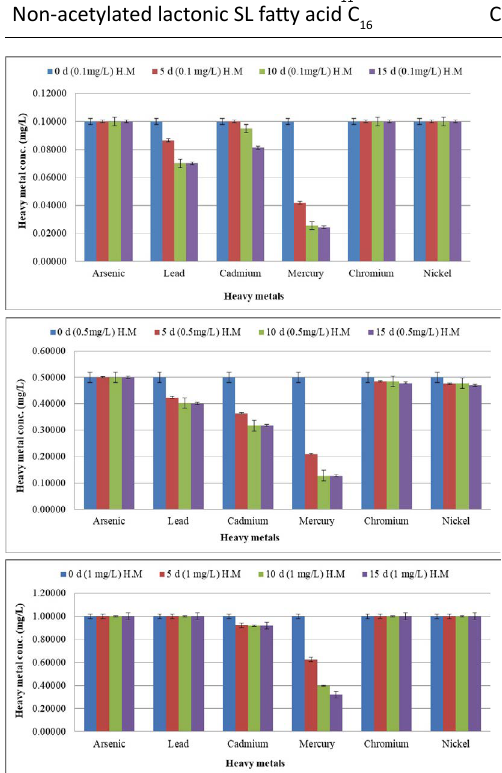
Fig. 9. Heavy metal ion biosorption by Candida tropicalis RA1 using (a) 0.1 mg l -1 (b) 0.5 mg l -1 and (c) 1.0 mg l -1 concentration of heavy metal